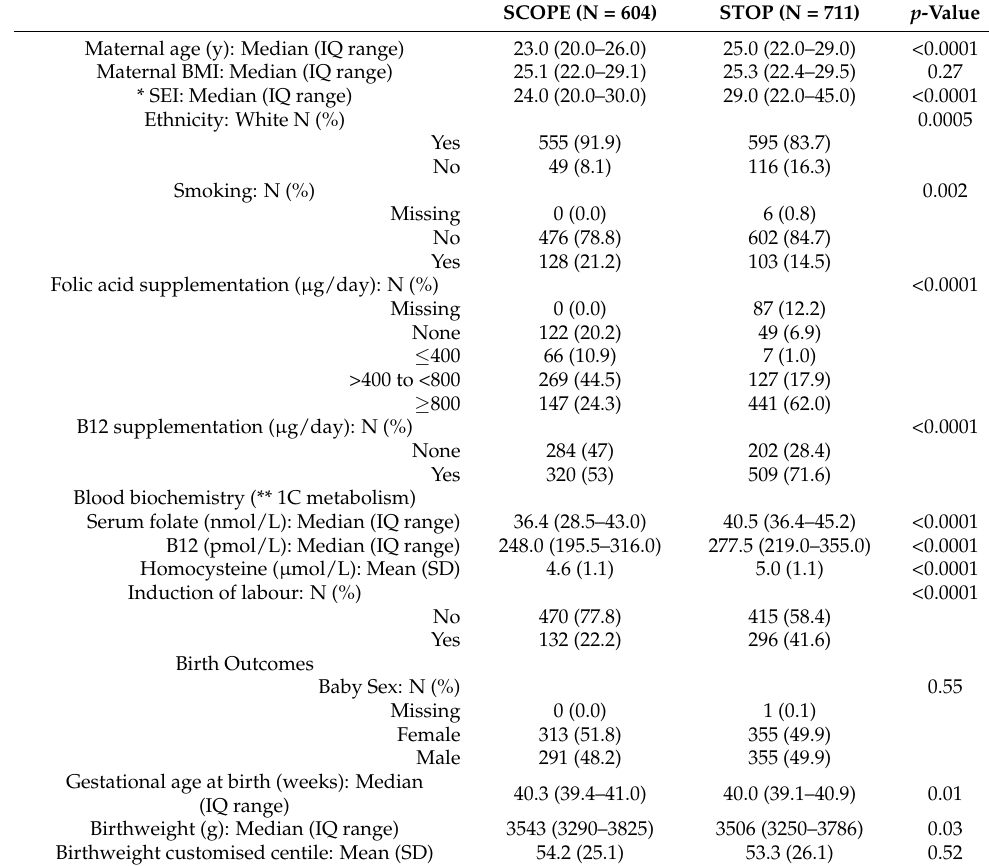
Table 1. Maternal characteristics measured in early gestation for SCOPE (14–16 weeks of gesta- tion) and STOP (6–16 weeks) women and term pregnancy and birth outcome data for those with uncomplicated